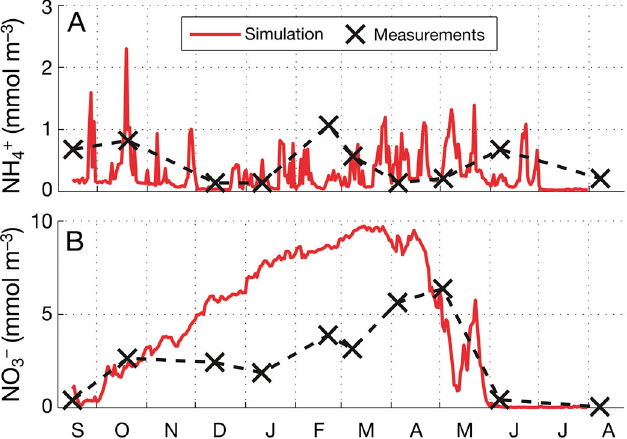
Fig. 6. Time series of simulated (Simulation B Aug,N , solid red line) and measured (black crosses and dashed line) inte- grated (0 to 8 m) (A) NH 44 and (B) NO 3– concentrations at the fish farm